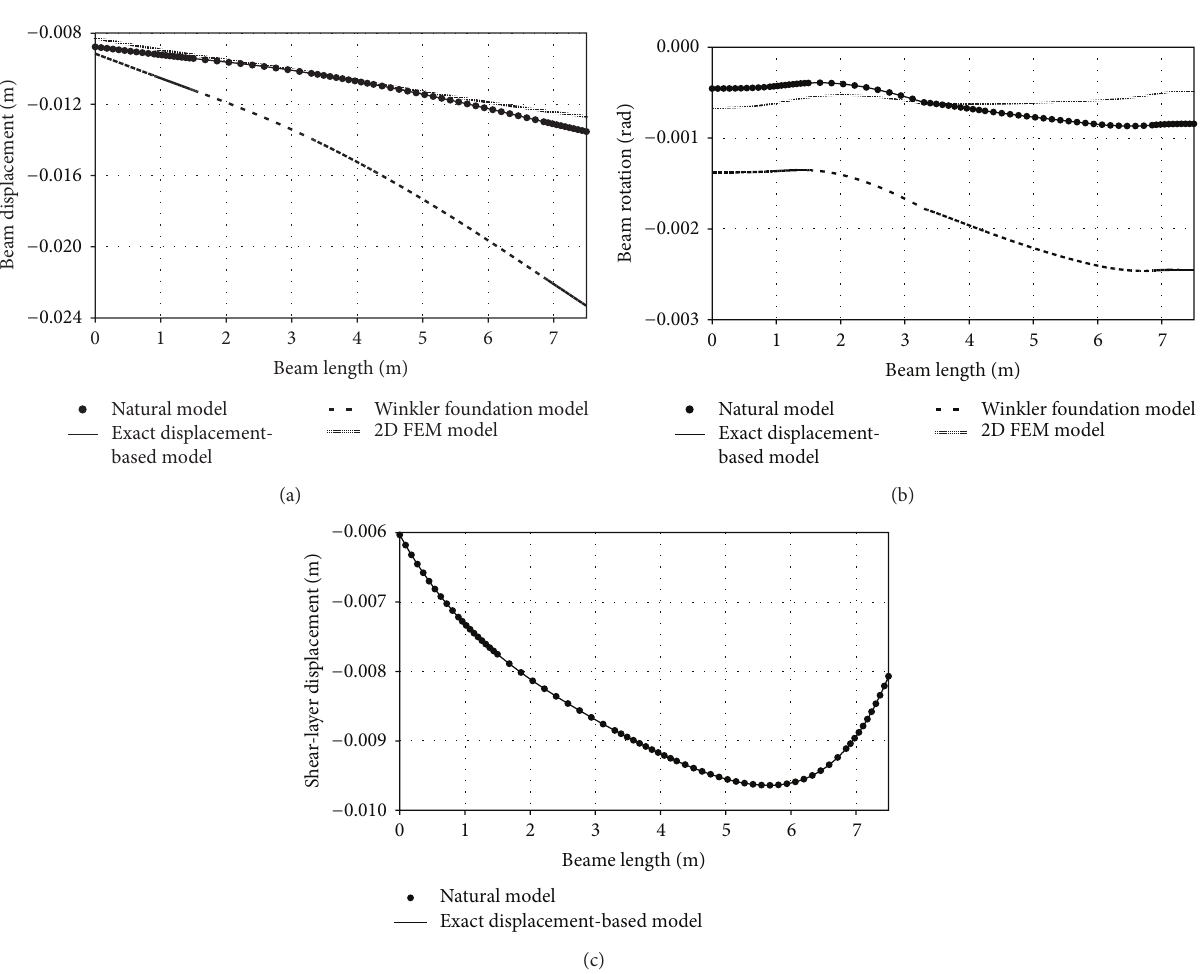
Figure 5: Diagrams for beam displacement, beam rotation, and shear-layer